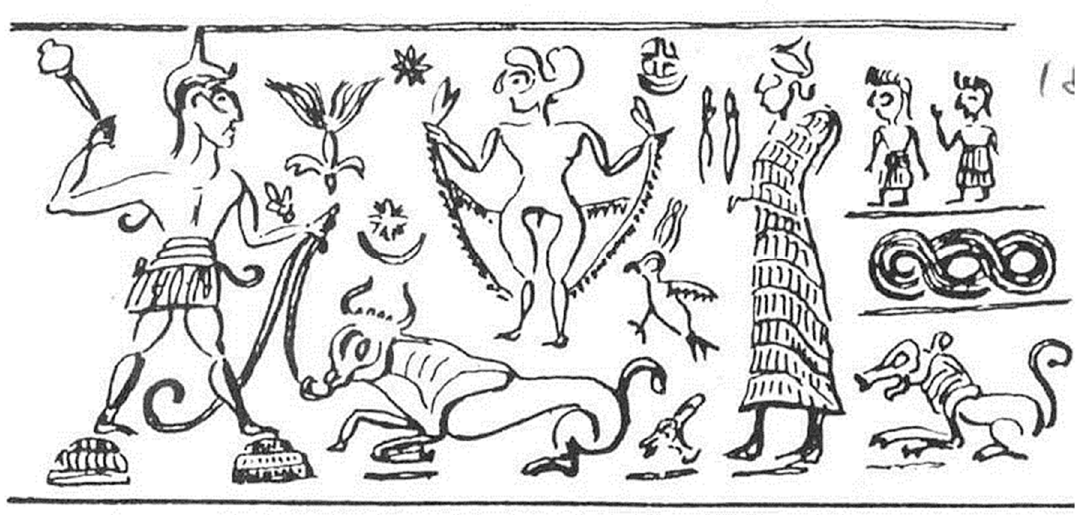
Figure 9. Syrian seal showing goddess lifting her skirt on a bull tethered by the storm god (Amiet 1960: Figure 14).